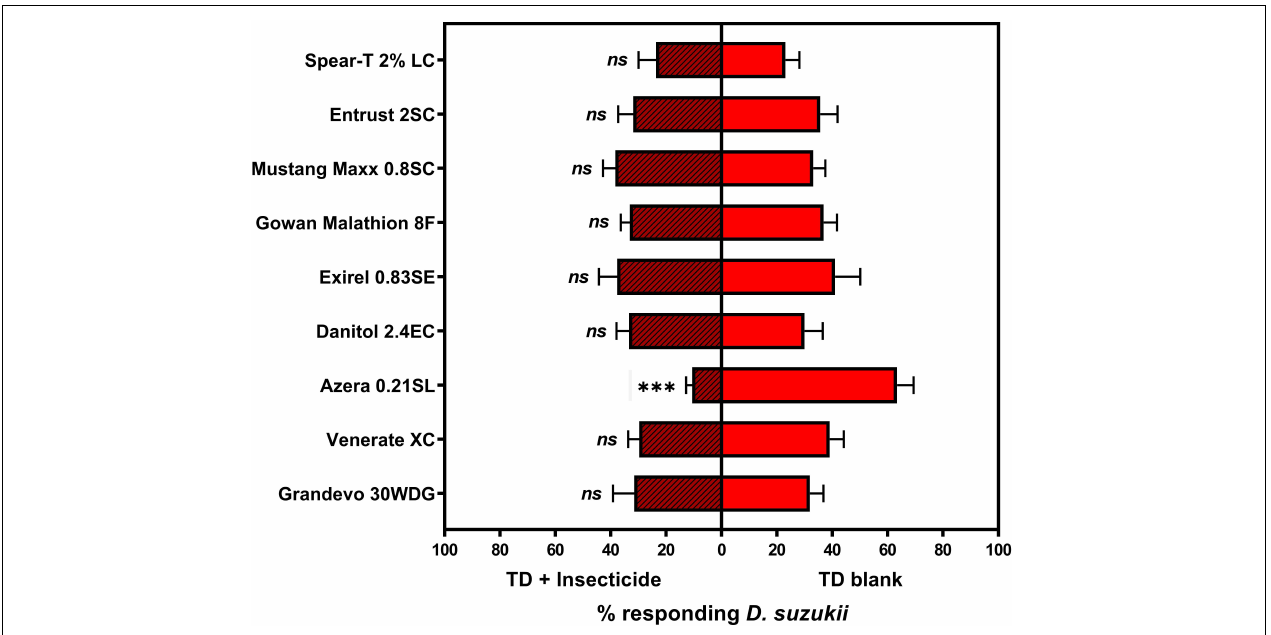
FIGURE 4 | Mean ( ± SEM) percent of total Drosophila suzukii released in an arena captured inside the traps contains an ACTTRA SWD TD + insecticide treatment vs. trap containing blank ACTTRA SWD TD. “ ns ,” no statistical difference (paired t -test; α = 0.05); significant difference, ∗∗∗ P < 0.001. For TD + Grandevo 30WDG vs. TD blank: N = 8, df = 7, t = 0.040, P = 0.9692; TD + Venerate vs. TD blank: N = 8, df = 7, t = 1.644, P = 0.1443; TD + Azera 0.21SL vs. TD blank: N = 8, df = 7, t = 7.121, P = 0.0002; TD + Danitol 2.4EC vs. TD blank: N = 8, df = 7, t = 0.343, P = 0.7415; TD + Exirel 0.83SE vs. TD blank: N = 7, df = 6, t = 0.213, P = 0.8385; TD + Gowan Malathion 8F vs. TD blank: N = 8, df = 7, t = 0.541, P = 0.6051; TD + Mustang Maxx 0.8SC vs. TD blank: N = 8, df = 7, t = 0.775, P = 0.4635; TD + Entrust 2SC vs. TD blank: N = 8, df = 7, t = 0.346, P = 0.7397; and TD + Spear-T 2% LC vs. TD blank: N = 8, df = 7, t = 0.067, P =